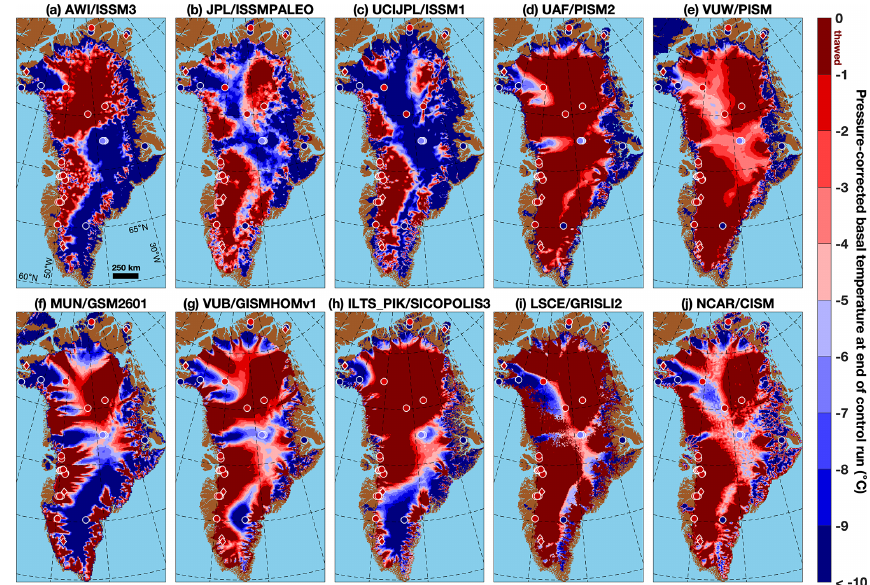
Figure 2. Modeled basal temperature ( T (cid:48) b ) across the GrIS at the end of 10 IMSIP6 control-run experiments, corrected for pressure melting using each instance’s ice-thickness field. The highest temperature range shown (darkest red) represents the range of basal temperatures we consider thawed for our “standard” temperature threshold. Symbology follows Fig. 1, except that the color for borehole symbols instead follows the color scale for their reported or apparent values of T (cid:48) b .